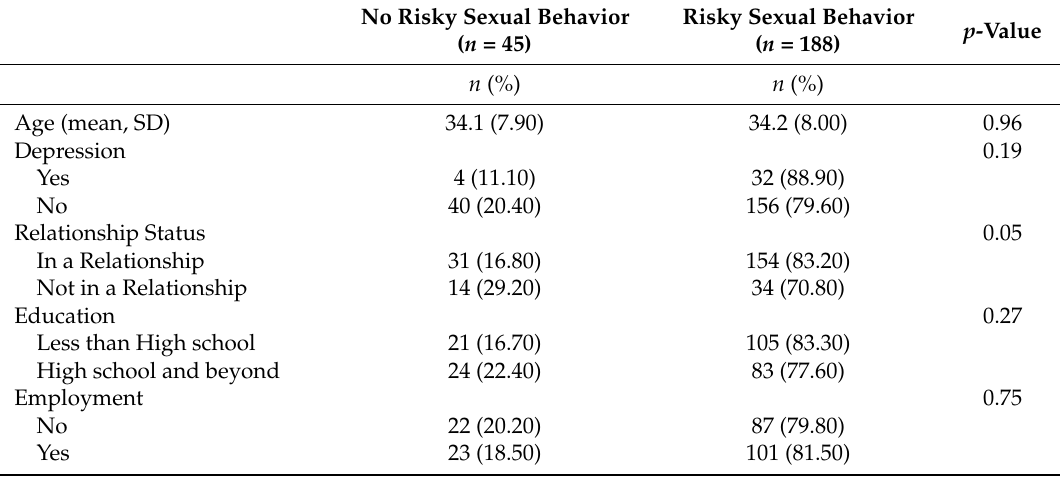
Table 2. Characteristics of adult Latina immigrant sample by risky sexual behavior in SEPA study in Miami-Dade County in South Florida in 2014–2016. No Risky Sexual